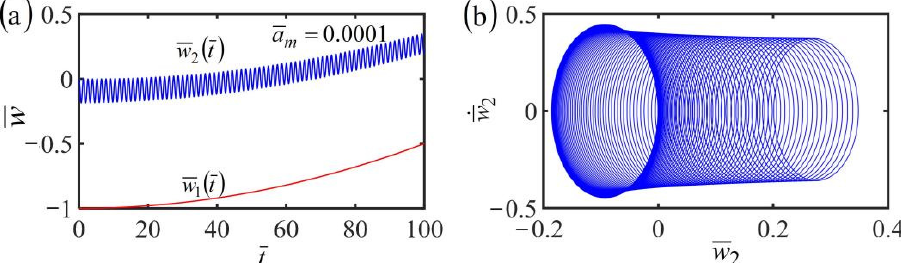
Figure 9. ( a ) Time history of the displacement and ( b ) phase trajectory of the self-oscillation of the